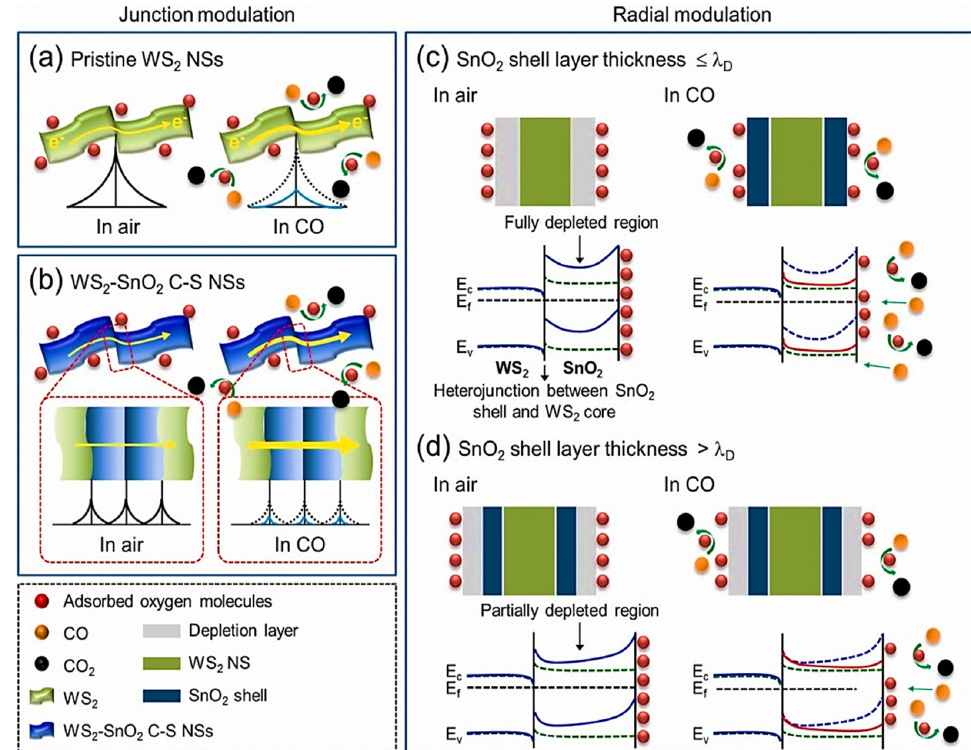
Figure 21. Schematic of the modulation of homojunction in ( a ) pure WS 2 NSs and ( b ) WS 2 -SnO 2 C-S NSs. Radial modulation in the sensors with shell thicknesses of ( c ) < λ D and ( d ) > λ D . Reproduced from [114] with the permission of Elsevier.